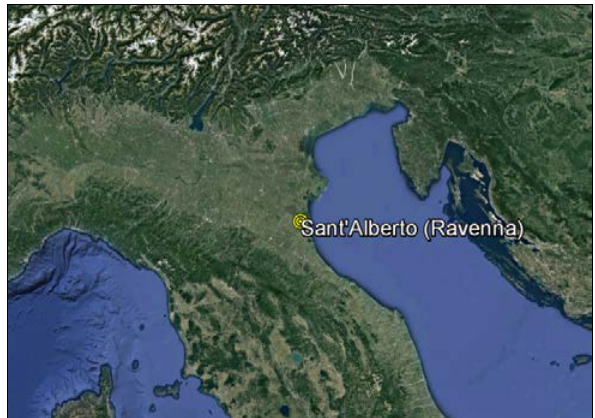
Figure 1. Location of Sant’Alberto town in Italy.